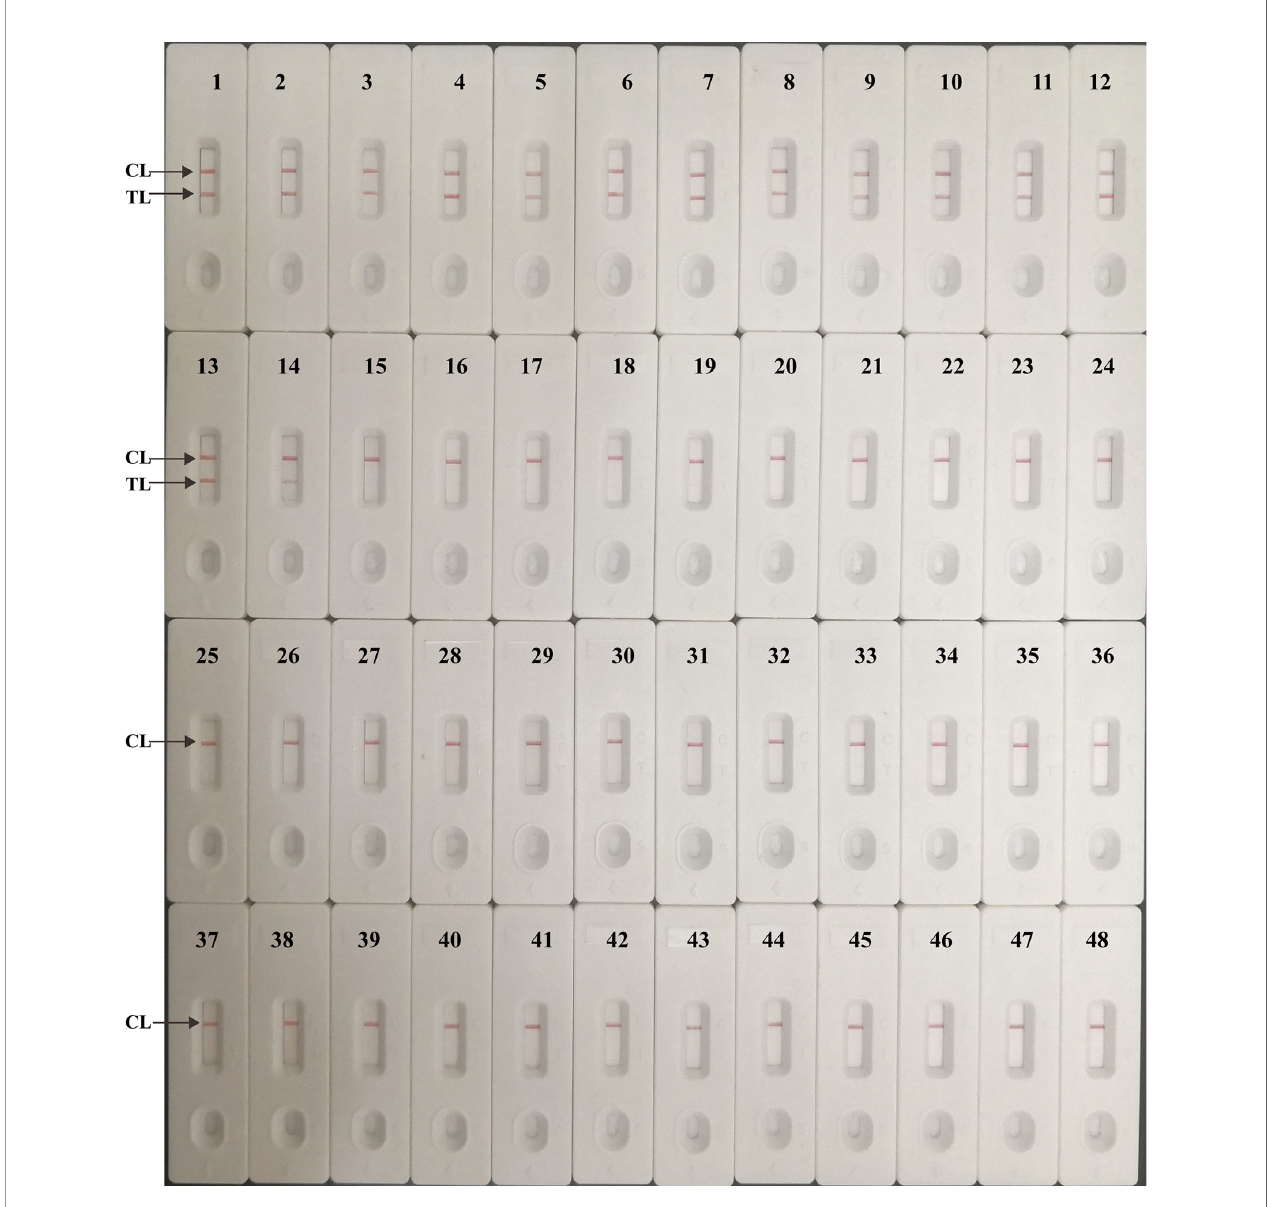
FIGURE 7 | Analytical speci fi city of multiplex LAMP-LFB assay. The multiplex LAMP assays were carried out using various genomic DNA templates, and were monitored by LFB. Biosensor 1, H37Rv; Biosensor 2, BCG; Biosensors 3-14, 12 MTB strains isolated from clinical patients; Biosensors 15-22, 8 different NTM strains (details shown in Table 2 ) ; Biosensor 23-47, 25 non-mycobacteria bacteria strains (details shown in Table 2 ); Biosensor 48,